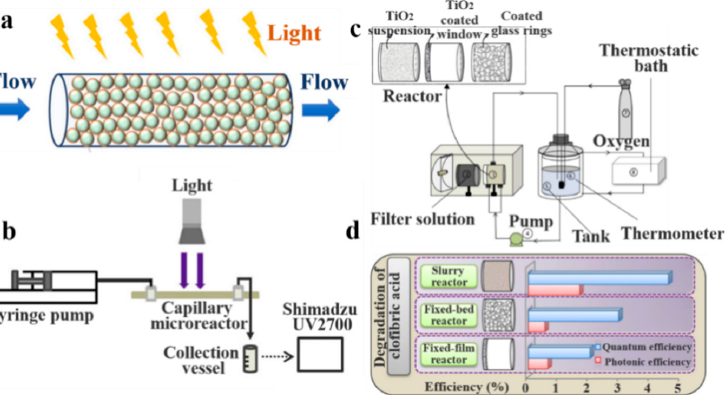
Figure 12. Schematic representation of packed-bed reactor with TiO 2 coated on glass beads ( a , b ) [138]. Copyright 2018, Elsevier. Experimental installation and photocatalytic performance of fixed bed reactor, slurry reactor and fixed film reactor ( c , d ) [48]. Copyright 2017, Elsevier.